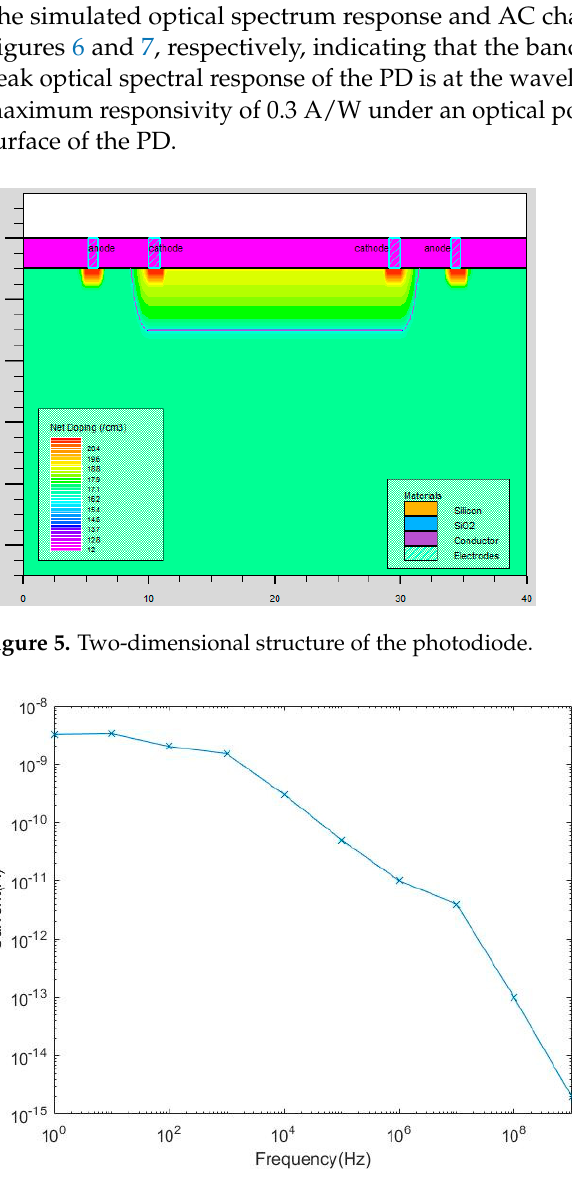
Figure 6. Simulated AC characteristic curve of the PD.